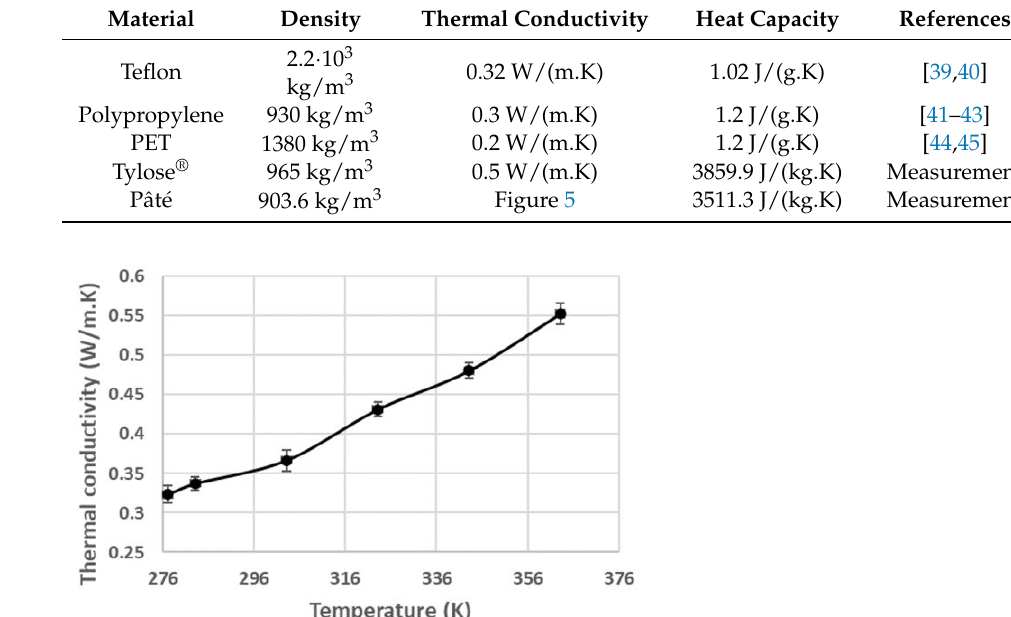
Table 4. Thermophysical properties of the materials used for heat-transfer modeling.